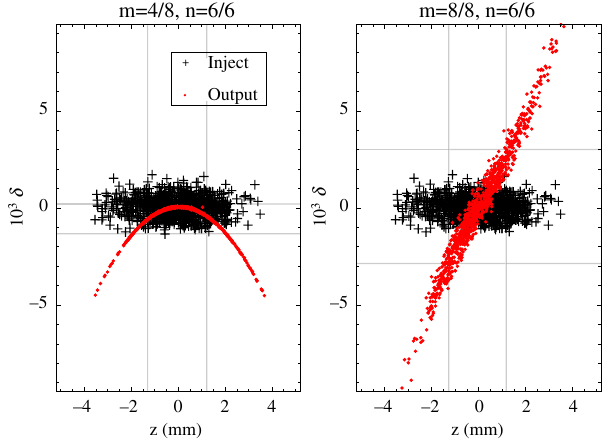
FIG. 4. Time evolution of 1000-particle Gaussian beam in longitudinal phase space: an initial Gaussian (both plots, over- laid), the beam after complete acceleration (left), and at beam stop (right). The beam is in an FT model ERL with M ¼ 8 , N ¼ 6 , and the ERL is set with ideal particle solutions (Table II). The ideal particle is defined at coordinates ð z; δ Þ ¼ ð 0 ; 0 Þ . Vertical and horizontal lines represent one standard deviation of the stated output from the mean z or δ